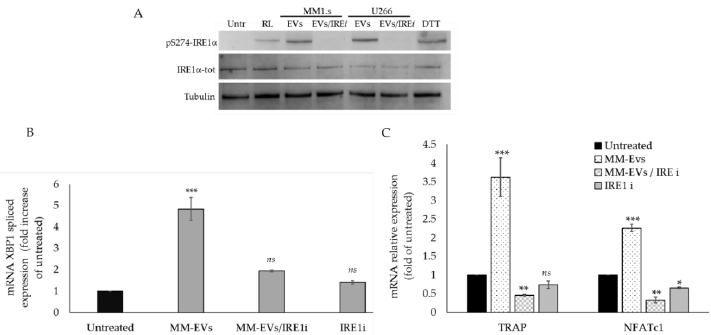
Figure 3. ( A ). Western blotting analysis of pS724-IRE1 α and IRE1 α -tot in Raw264.7 cells treated for 6 h with 25 µ g / mL of EVs-MM1.s and EVs-U266, with 200 nM GSK2850163 (IRE1 α inhibitor: IRE1 ι ) and co-treated with MM-EVs and IRE1i; as positive controls, Raw264.7 cells were also treated with 10 mM DTT (reducing agent used as UPR inducer). Tubulin was used as loading control. ( B ). qRT-PCR analysis of XBP1 spliced in Raw264.7 cells treated for 6 h with 25 µ g / mL of MM-EVs, with 200 nM GSK2850163 (IRE1 ι ) and co-treated with MM-EVs and IRE1 ι . Data were normalized for GAPDH and values are expressed as fold of control (untreated cells). ( C ). qRT-PCR analysis of Trap and Nfatc1 in Raw264.7 cells treated for 6 h with 25 µ g / mL of MM-EVs, with 200 nM GSK2850163 (IRE1 ι ) and co-treated with MM-EVs and IRE1 ι . Data were normalized for GAPDH and values are expressed as fold of control (untreated cells). The statistical significance of the differences was analyzed using a Dunnett’s test (treated Groups